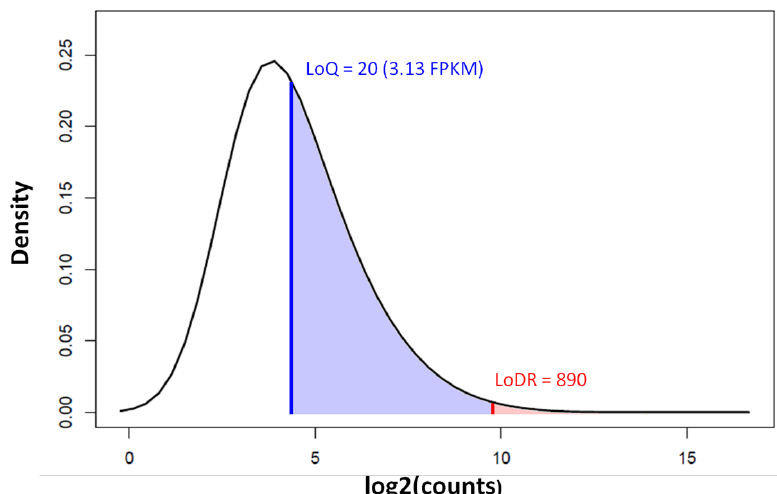
Figure 8. Density distribution of circRNA counts by circRNA-seq in colorectal cancer and normal control samples (GEO Accession: GSE205241). The limit of quantification (LoQ) is indicated by the blue vertical line and the limit of differential ratio (LoDR, down to a 2-fold change) by the red vertical line. Less than 0.3% of the circRNAs are above the LoDR (shaded red). The circRNA-seq was run on Illumina NovaSeq 6000 at a 150 bp read length and a coverage of 40 million paired end fragments.